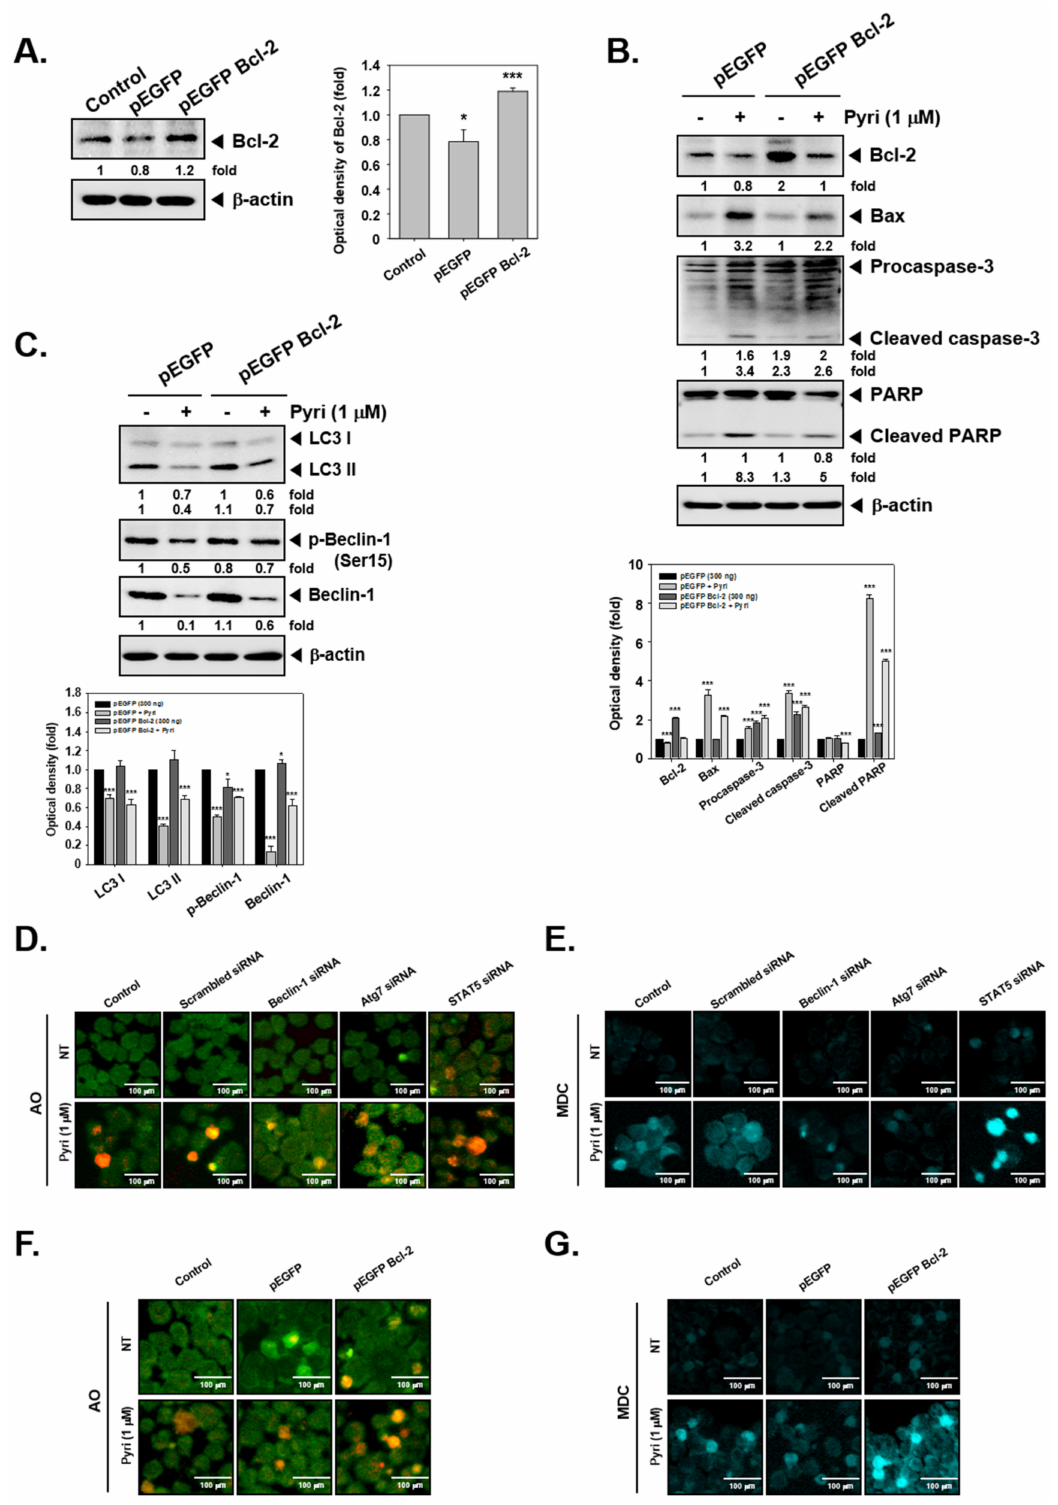
Figure 6. Pyri-induced cell death following Beclin, Atg7, STAT5, and Bcl-2 interference. ( A – C ) The possible effects of genetic overexpression of Bcl-2 on Pyri-mediated apoptosis and autophagy. The cells were treated with 1 µ M of Pyri for 24h, and then western blotting was performed. *** p < 0.001 vs. non-treated (NT) cells, * p < 0.05 vs. non-treated (NT) cells. ( D , E ) KBM5 cells (2 × 10 7 cells/well) were transfected with beclin-1, Atg7, and STAT5 siRNA for 48 h. Then treated with Pyri (1 µ M) for 24 h and analyzed by AO and MDC staining. ( F , G ) Bcl-2 was over expressed by pEGFP-Bcl-2 DNA. Then the cells were stained by AO and MDC. The results shown are representative of three independent